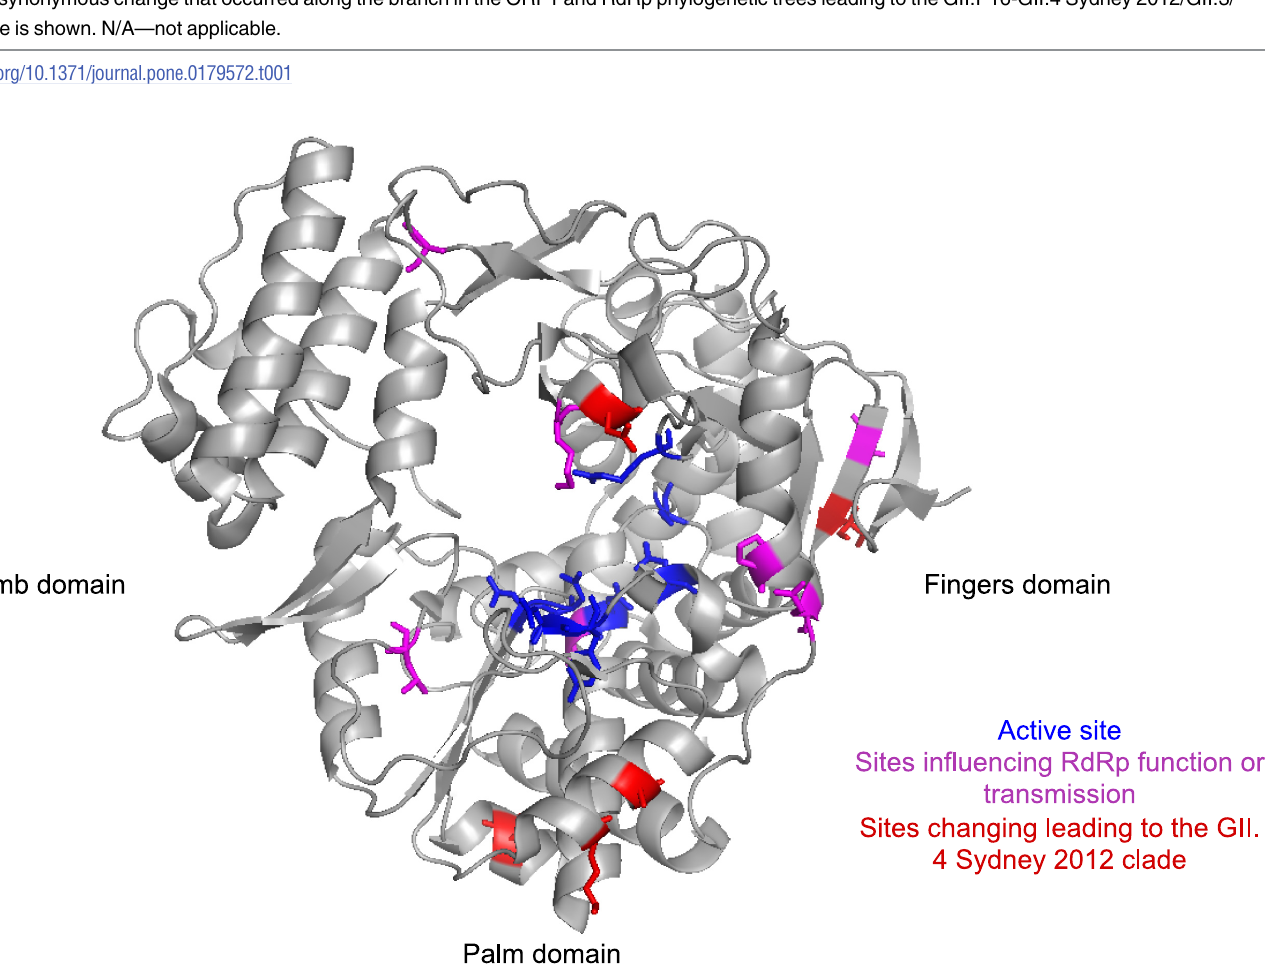
Fig 3. Location of RdRp sites that change leading to the GII.P16-GII.4 Sydney 2012 clade. Sites are highlightedon PDB structure 1SH0. The sites that change leadingto the GII.P16-GII.4 Sydney 2012 clade are shown in red. The sites that form the RdRpactive site are shown in blue. Sites previously demonstrated to alter RdRp function and/or transmissionwhen mutated are shown in magenta(14,15).